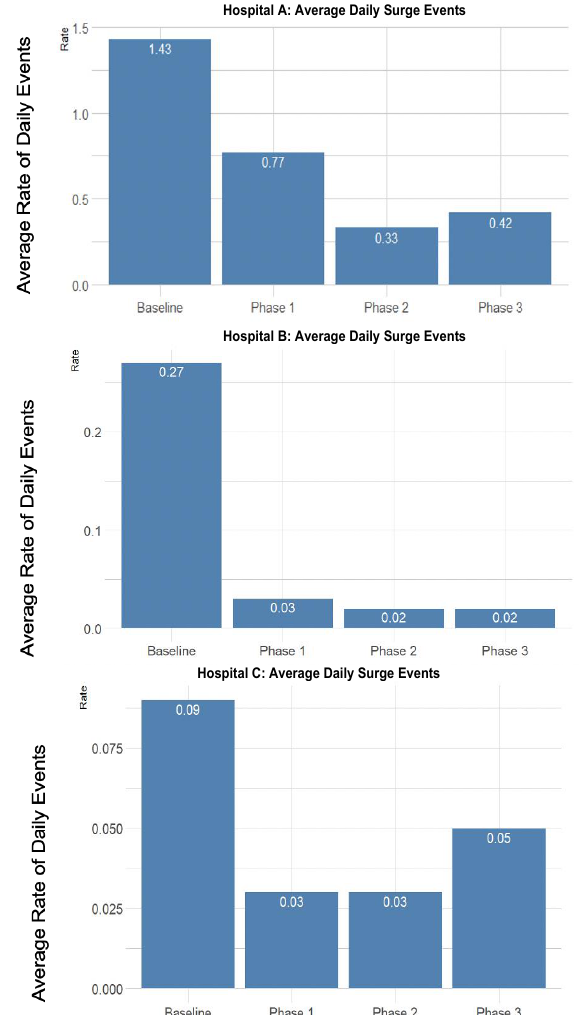
Figure 2. Comparing the average daily rate of surge events, in the different phases of the Centralized Ambulance Destination Diversion (CAD-D) project. Hospitals A, B and C showed decreased surge events in the CAD-D phases compared to baseline.